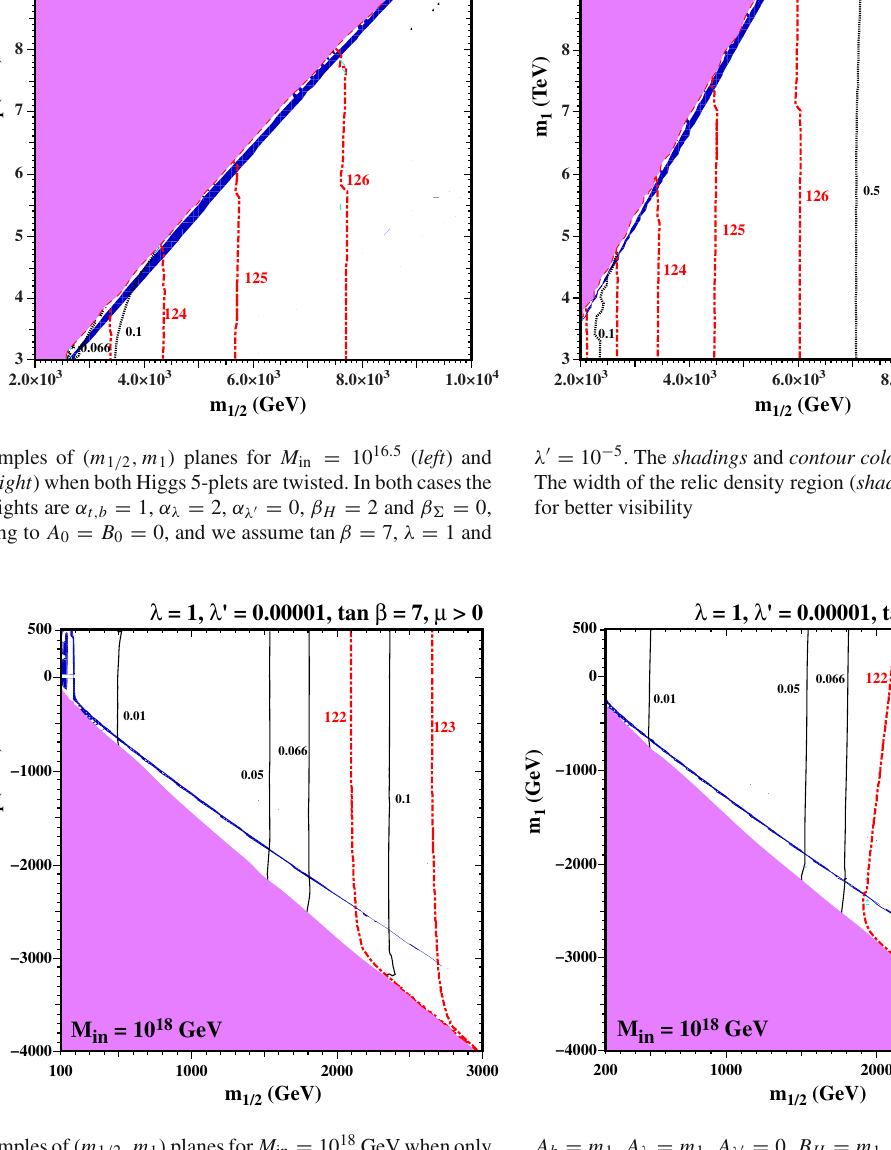
extends (barely visibly) to m h = 123 GeV (shown by the red dot-dashedcontours).Intherightpanelofthisfigure,wehave set all weights to zero, and therefore A t = 0, A b = m 1 , A λ = m 1 , A λ (cid:2) = 0, B H = m 1 , and B (cid:3) = 0. Qualitatively, the two figures are very similar. The strip extends to slightly larger m h but, again, not much past 123 GeV. In both cases, A t = 0 at the input scale and, although A b (cid:16)= 0 in the right panel,